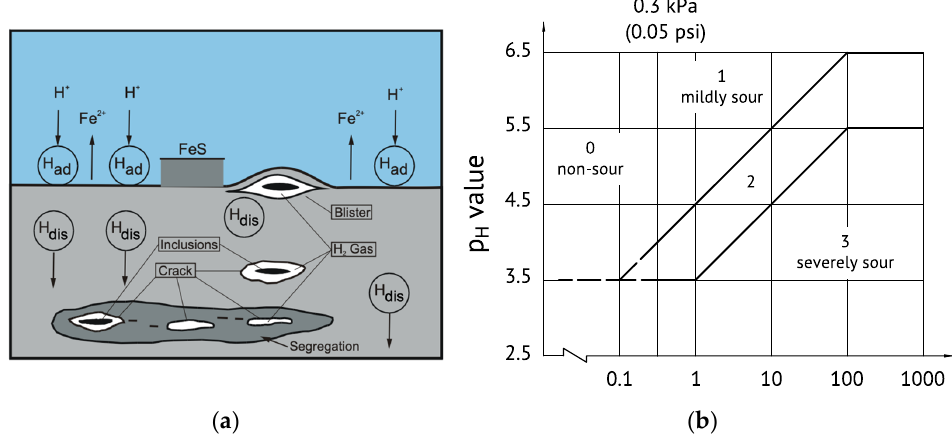
Figure 9. ( a ) Principle of hydrogen generation by a corrosive reaction at the steel surface and typical damage features by absorbed hydrogen in the steel; ( b ) definition of environmentally assisted cracking (EAC) severity regions according to ISO standard 15156-2.